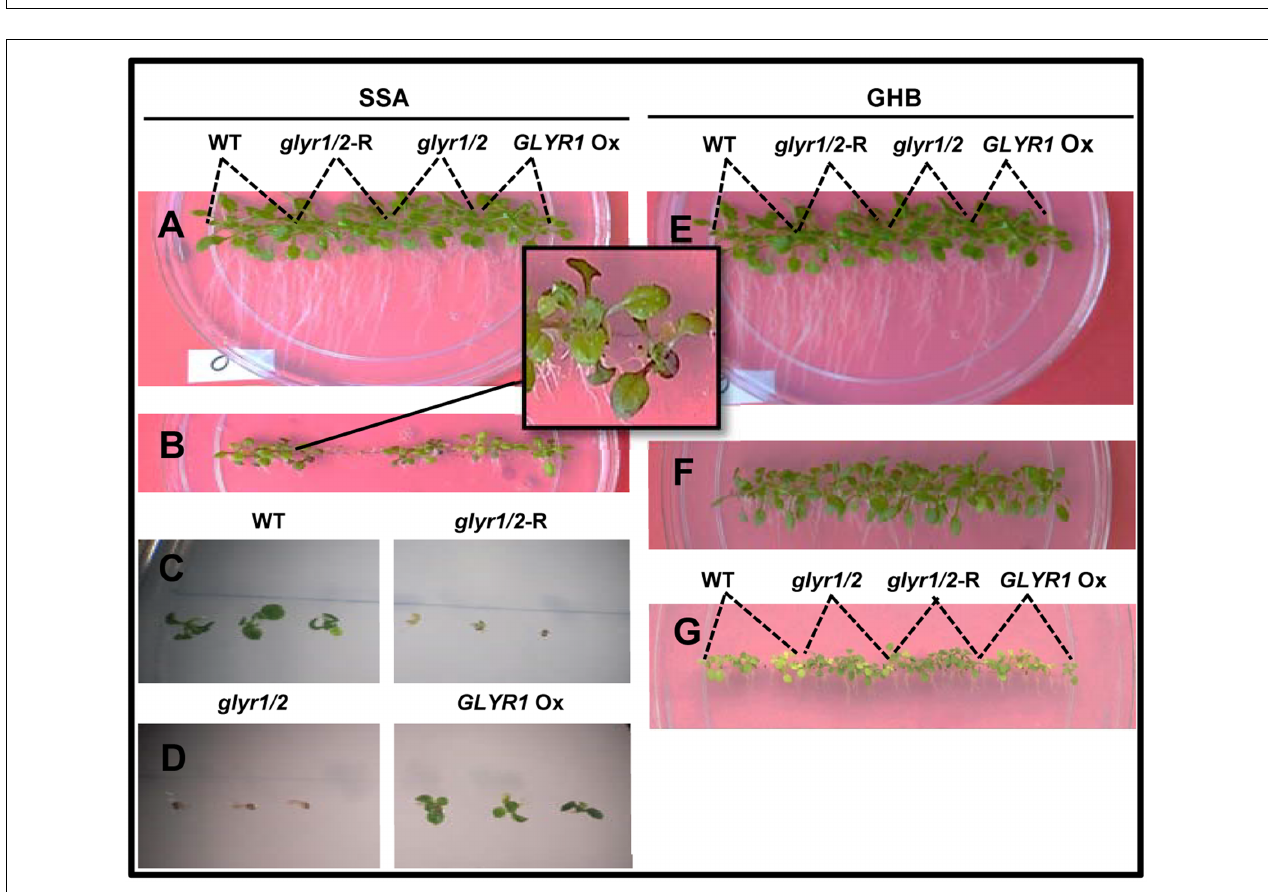
FIGURE 2 | Dependence of recombinant apple GLYR activities on NADP + /NADPH ratio. The activities of Md GLYR1 (A) and Md GLYR2 (cid:49) 54 (B) were determined using 50 µ M glyoxylate and NADPH, and increasing concentrations of NADP + . Data represent the mean ± SD of four technical measurements of a typical enzyme preparation.